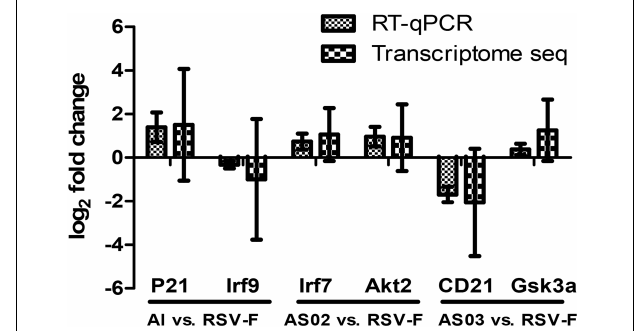
FIGURE 11 | Comparison of transcriptome sequencing and RT-qPCR results of the selected DEGs. Two DEGs from each paired group were selected to confirm the results of transcriptome sequencing. RT-qPCR results used the comparative threshold cycle (2 − (cid:49)(cid:49) CT ) method to calculate the gene expression. The y -axis shows the ratio of the gene expression between the adjuvant group and the simple antigen